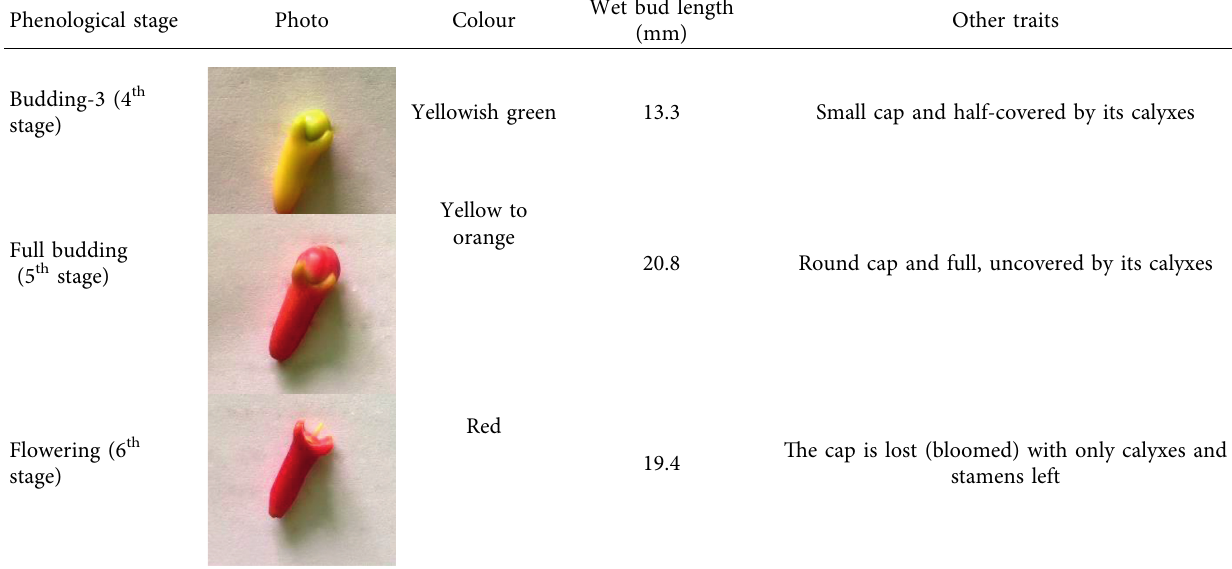
Table 1: Clove bud on three phenological